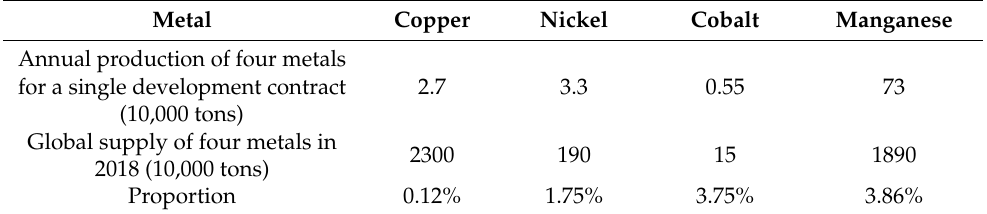
Table 14. Polymetallic nodule metal production in relation to land production for a single mining contract in the Clarion–Clipperton Fracture Zone